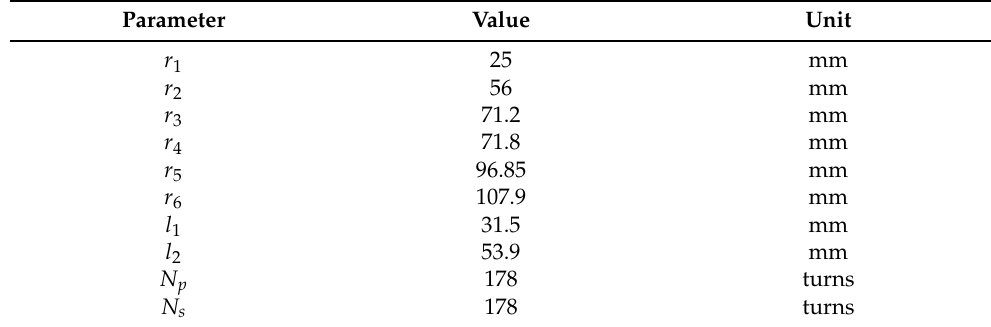
Table 2. Two kVA single-phase rotary transformer design dimensions.